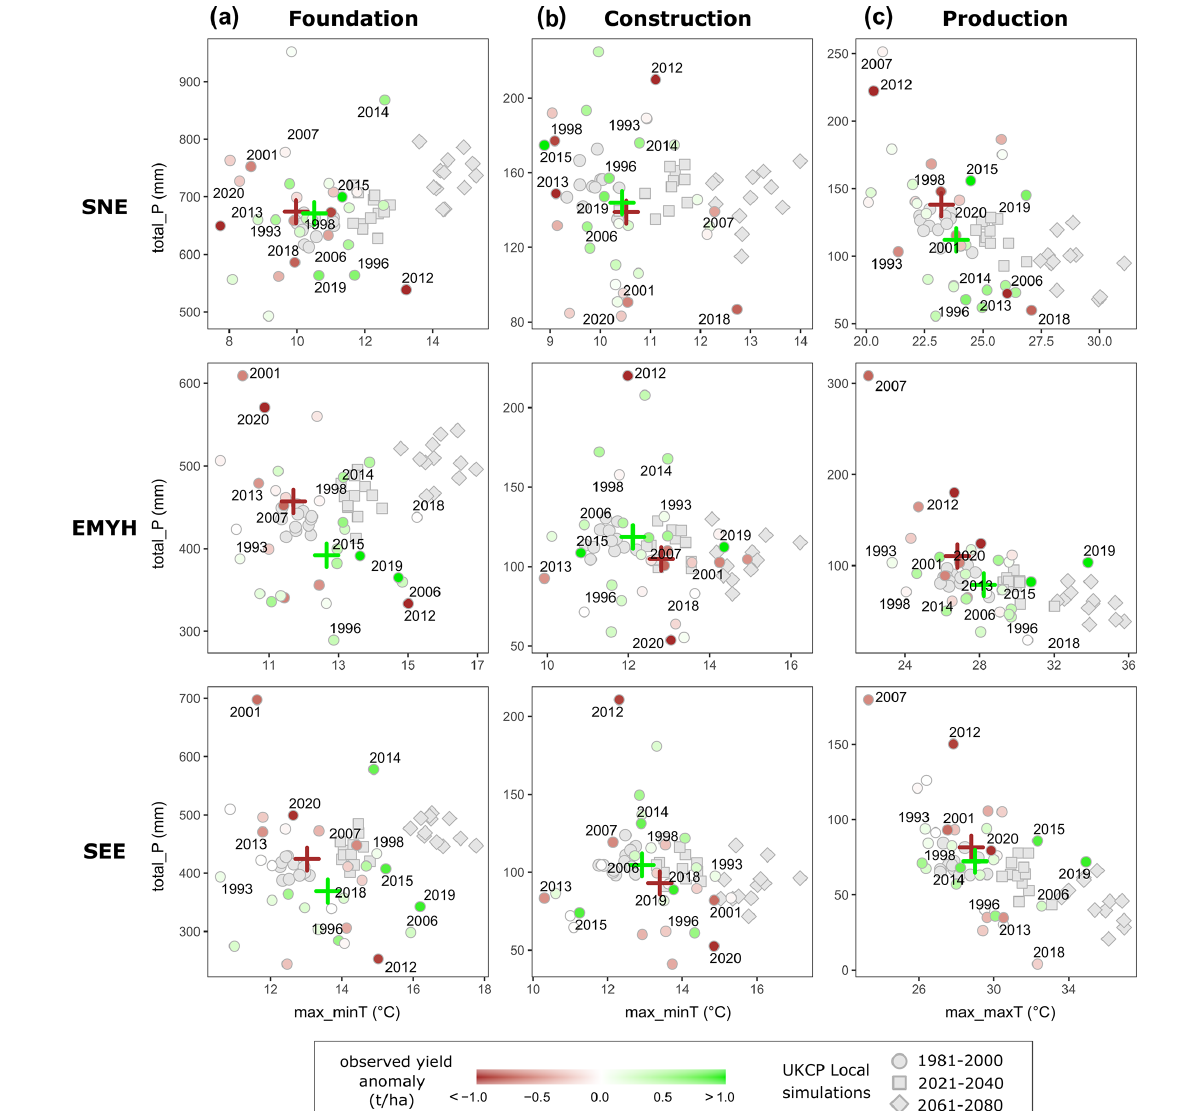
Figure 5. Association between wheat yields and climate during the three wheat-growing phases and in each of the three UK wheat- growing regions. Anomalies of observed UK wheat yields are shown for total area-averaged precipitation ( total_P ) and the area-averaged minimum/maximum daily temperature within each phase (i.e. the metrics total_P , max_minT , and max_maxT , chosen for their associations with crop yields; Table 2), alongside UKCP projections. Columns (a–c) : same as Fig. 4. Rows: SNE, EMYH, SEE. Yield time series are shorter at the regional scale than national (see Fig. 1b). Small green circles indicate positive yield anomalies for individual years; small brown circles indicate negative yield anomalies for individual years. Symbology is the same as Fig.